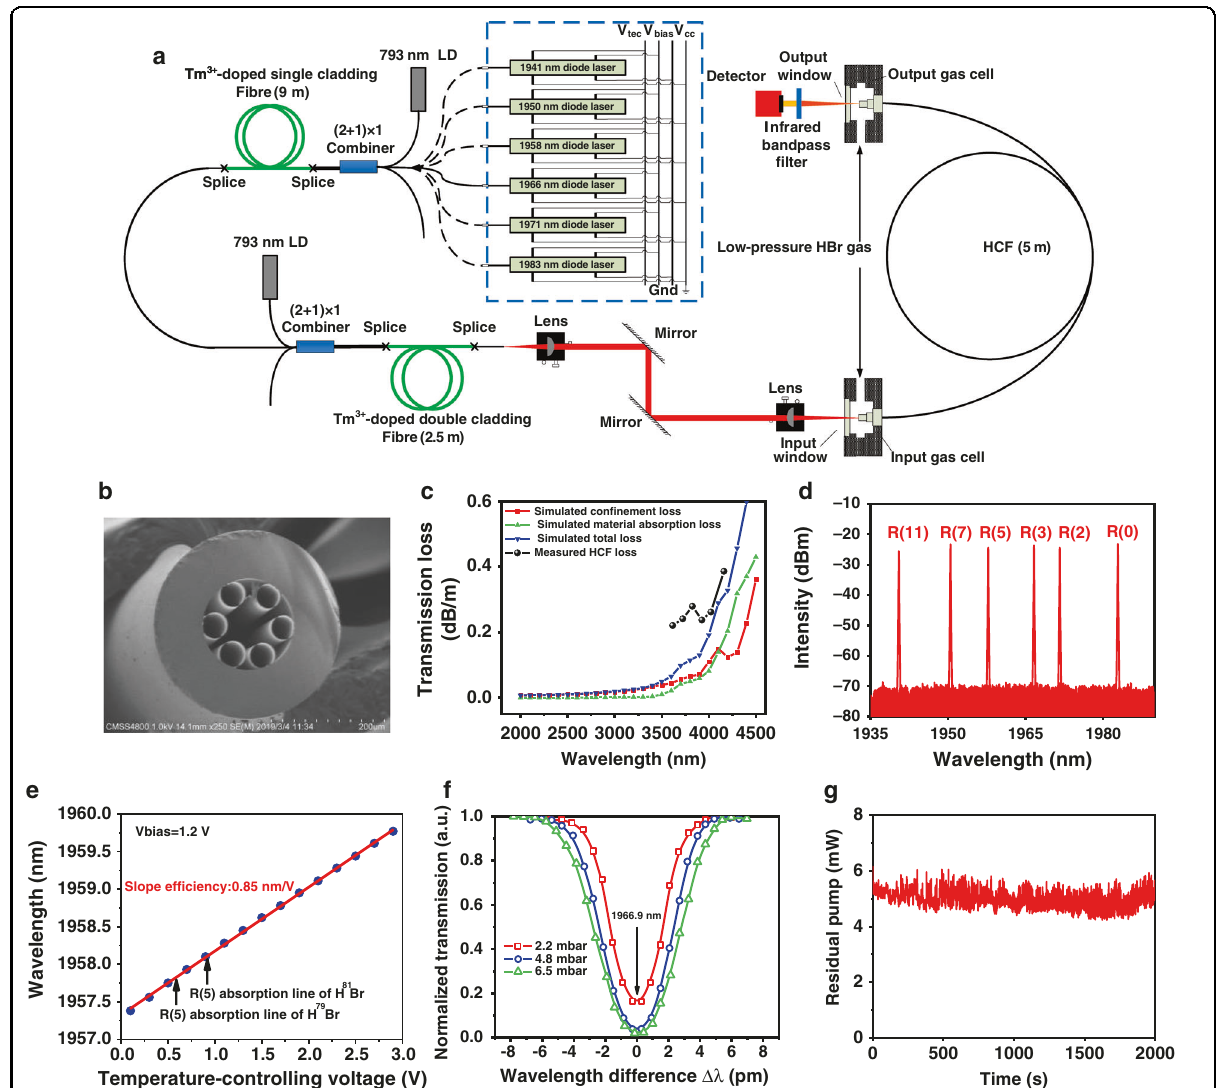
Fig. 3 Experimental layout and measured and calculated properties of the HCF and the homemade pump source. a Experimental layout for 4 μ m laser generation. b SEM images of the cross section of the HCF. c Comparison between simulated and measured loss of the HCF. d Measured spectrum of the pump system seeded by chosen absorption line wavelengths. e Output wavelength of the pump system changing with the Vtec of the R(5) diode laser. f Measured absorption line shapes of HBr under pressures of 2.2, 4.8 and 6.5 mbar seeded by the R(3) absorption line. g Variation in the measured residual pump power with time when tuned to the centre of the R(3) absorption